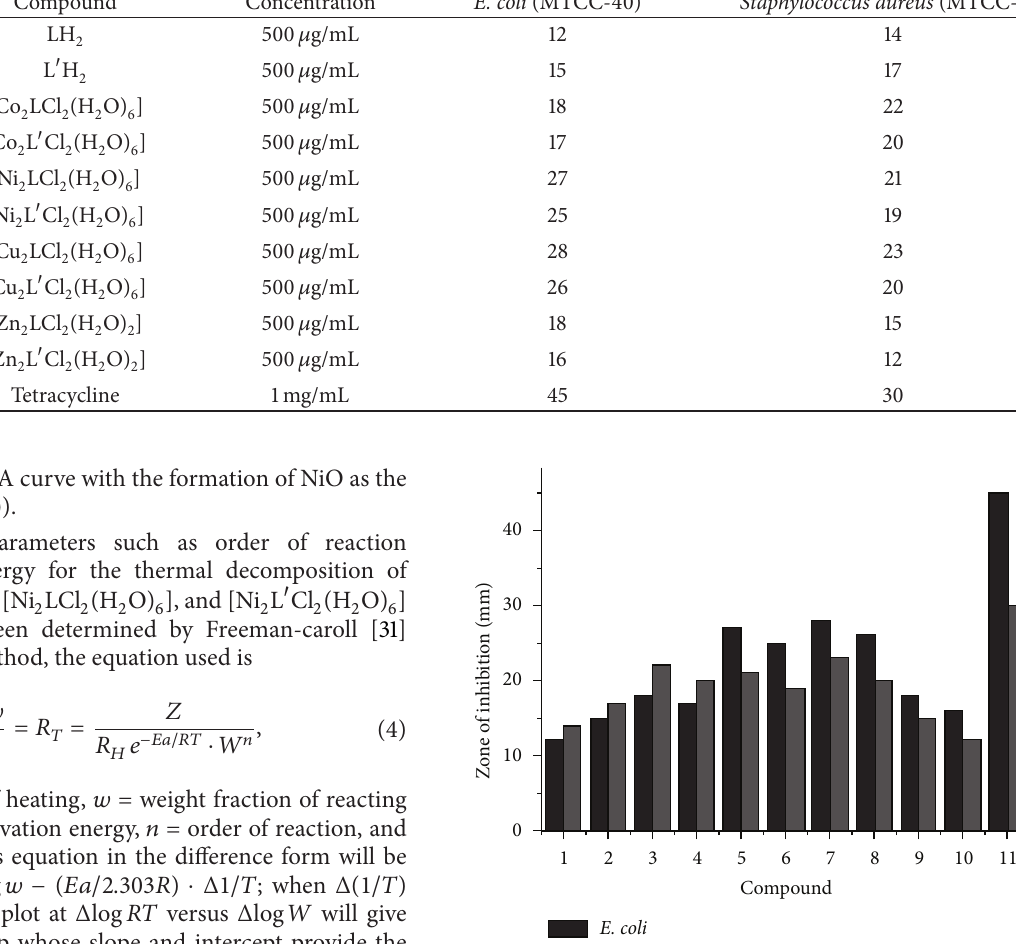
Table 6: Antibacterial activities of the ligands and the complexes (data presented as diameter of zone of inhibition, mm). Serial no.